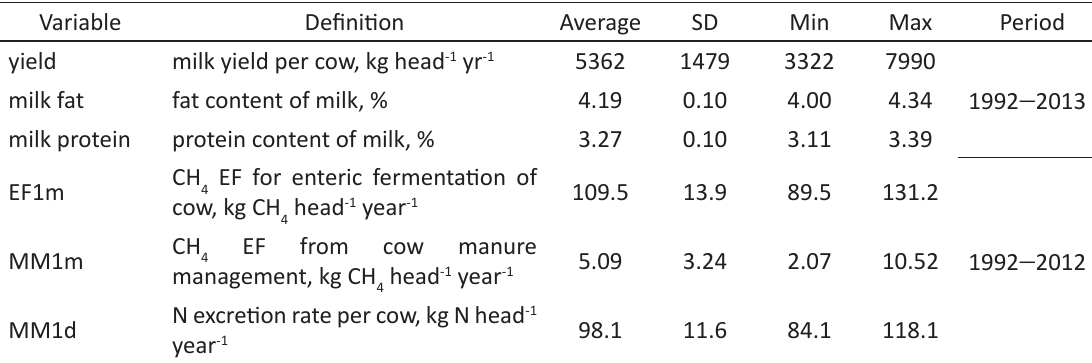
Table 1. Definitions and descriptive statistics of key